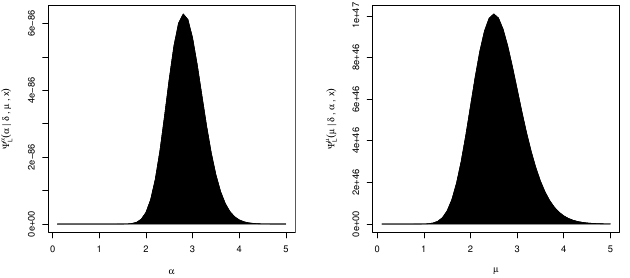
Figure 2. Diagram plot of the conditional PDFs based on LF of α and µ